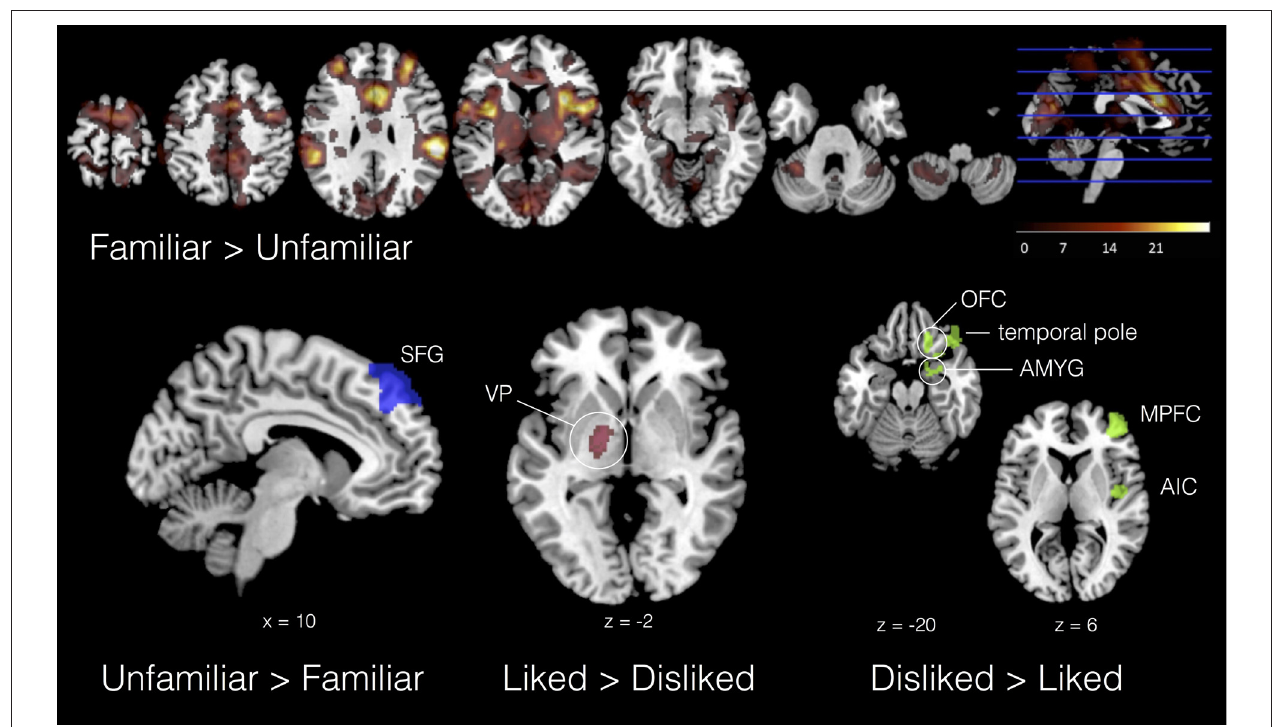
FIGURE 4 | Selected results from four basic contrasts. Familiar > Unfamiliar displayed as heat map in seven axial slices; UNFAMILIAR > FAMILIAR = blue; LIKED > DISLIKED = red; DISLIKED > LIKED = green. All contrasts, Z > 2.3, p < 0.01 (cluster corrected, p <